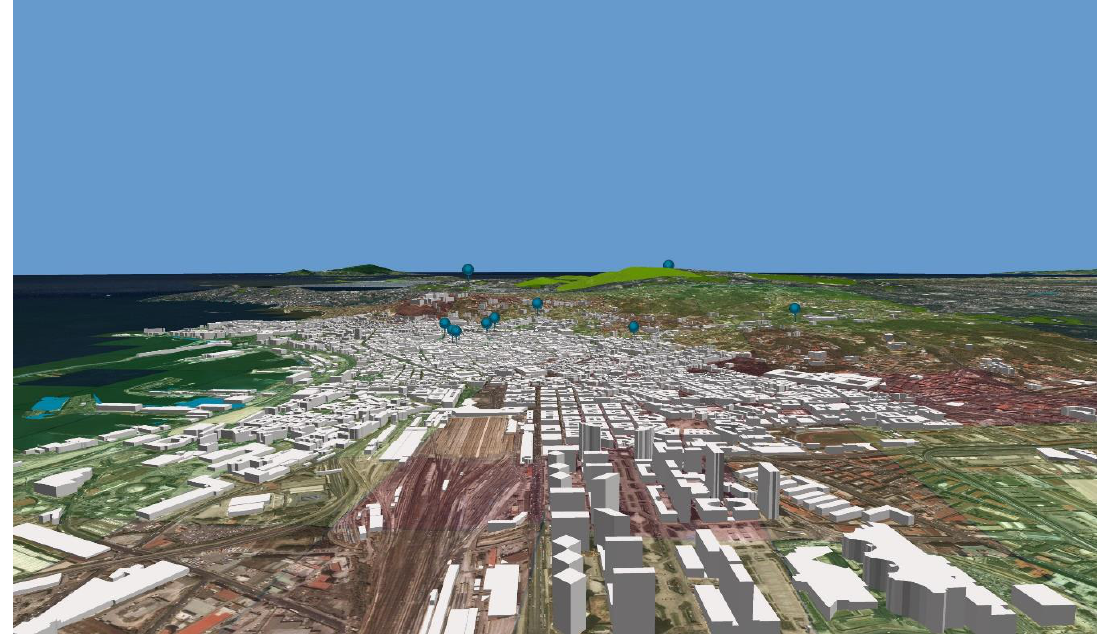
Figure 4. Excerpt of the 3D city model with the Urban Ecosystem Services (UES) grid overlapped. The spatial relationships among building z-values and Regulation Services cell values are visualised.